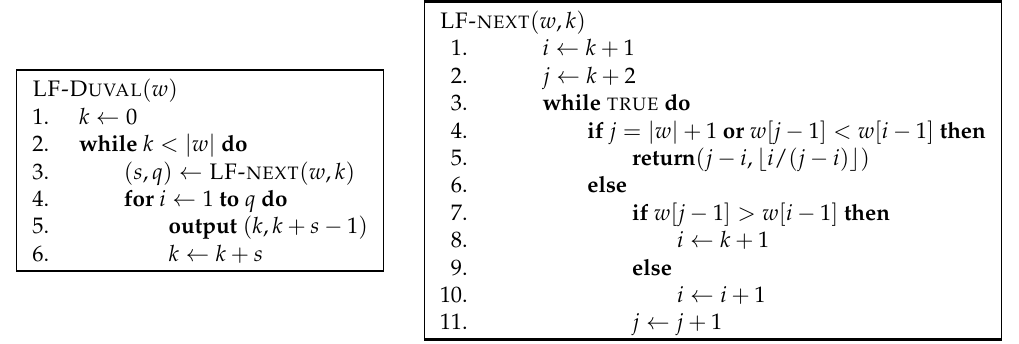
Figure 1. Duval’s algorithm to compute the Lyndon factorization of a